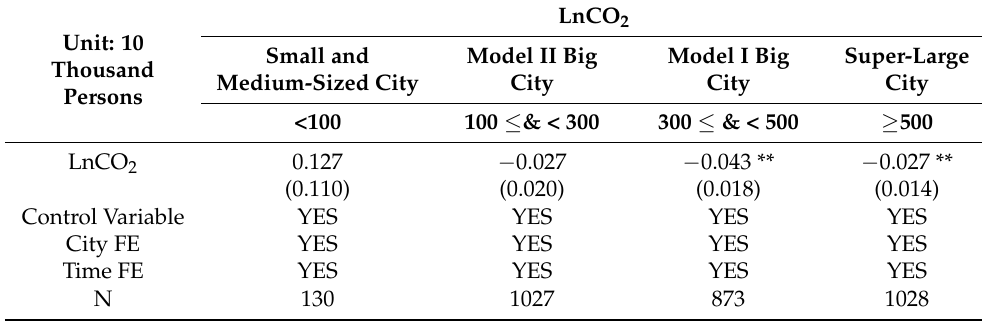
Table 12. Heterogeneity of city